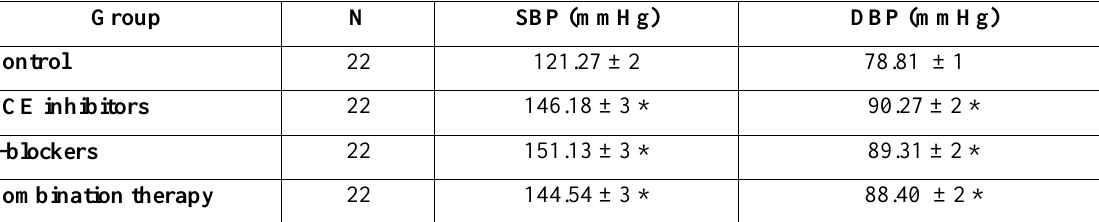
Table 3: Lipid profiles (TC, TG, HDL, LDL and VLDL) in control healthy individuals and hypertensive patients treated with different antihypertensive drug regimens and HMG-CoA reductase inhibitors. Each value represents mean± standard error of mean.